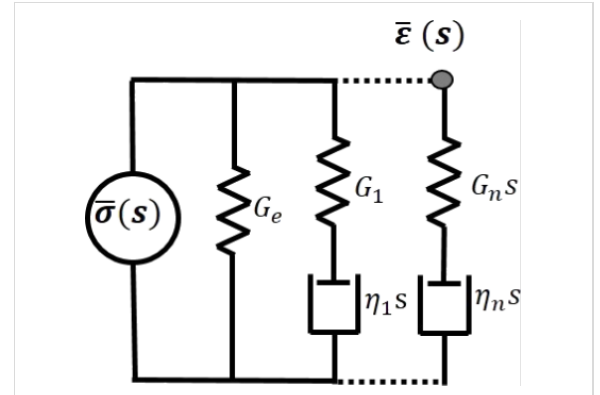
Figure 1: Generalized Maxwell or Wiechert mechanical model diagram representing the relationship between stress and strain in the complex plane for a linear viscoelastic material with multiple characteristic times. This model describes arrheodictic (there is no steady-state flow) behavior. G n refers to the modulus of the n -th spring. η n refers to the viscosity of the n -th dashpot. G e refers to the rubbery modulus. The Laplace transformed stress is regarded as the excitation and the transformed strain as the